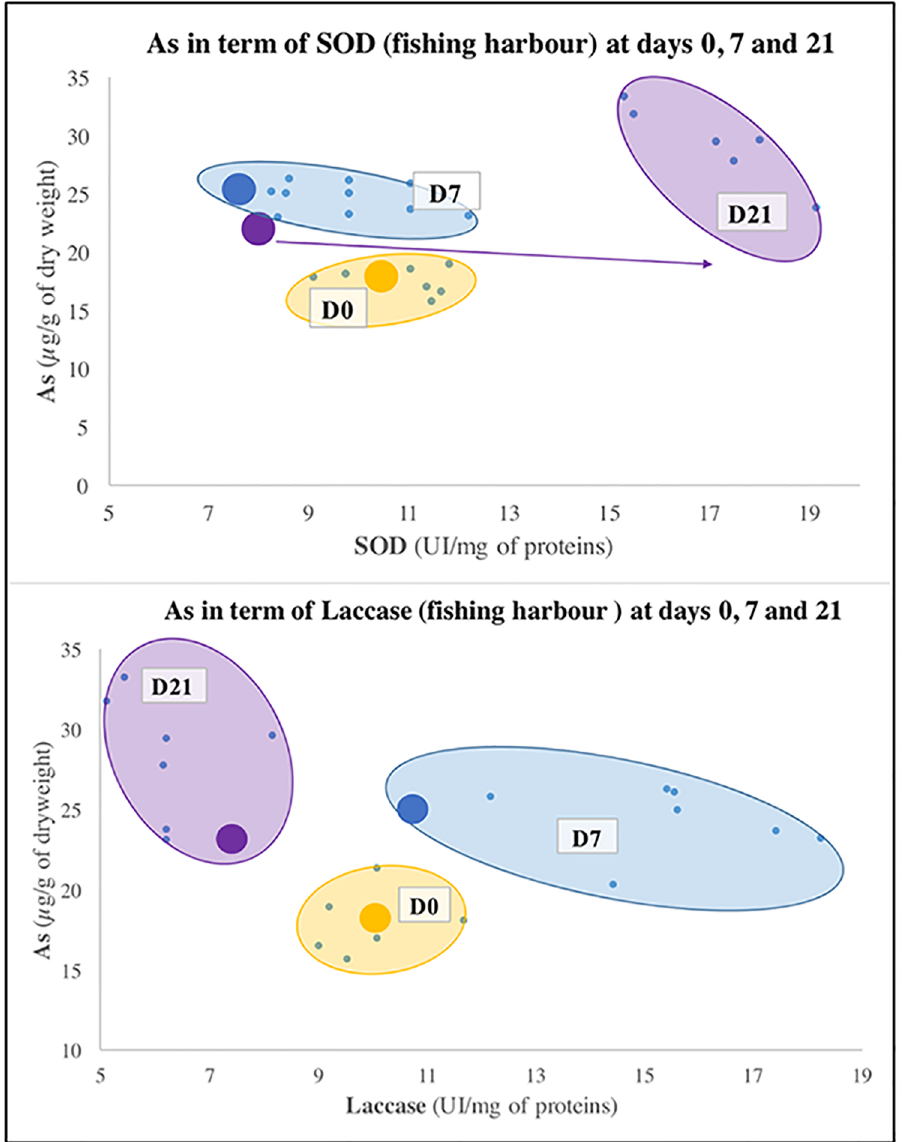
Fig 8. Specific pollution of as depending on SOD (struggle against ROS) and Laccase (immunomodulation) at the fishing harbour.